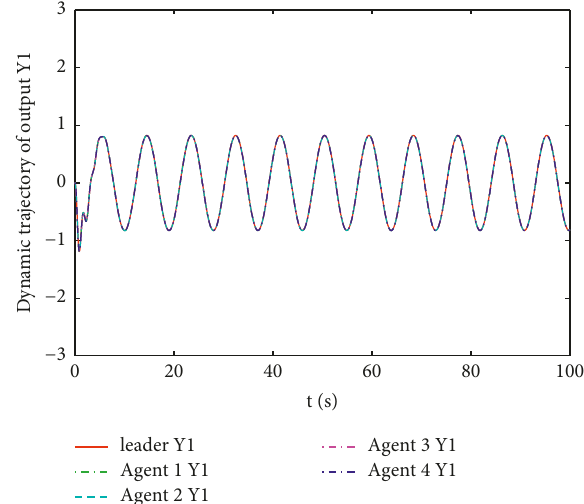
Figure 6: Profiles of output trajectories y